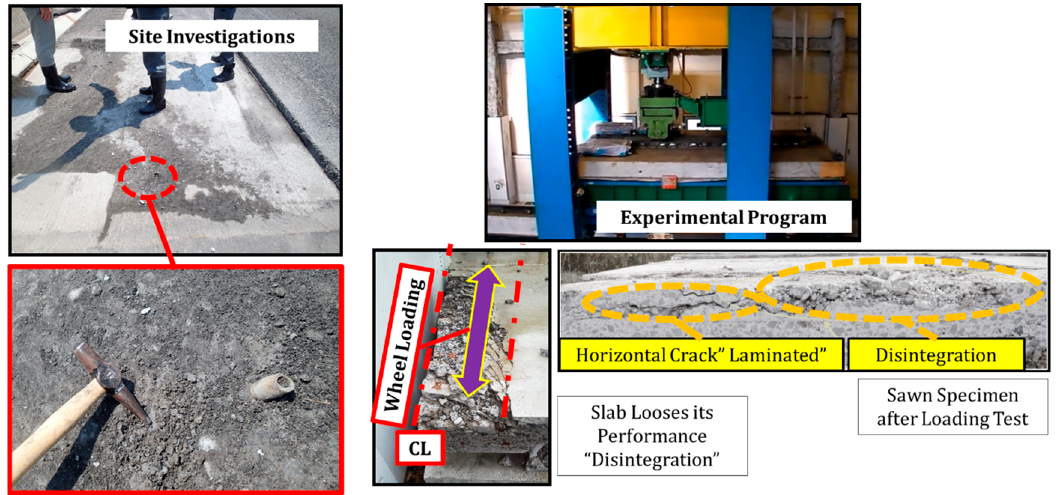
Figure 1. Site and experimental investigations for the disintegration phenomenon.